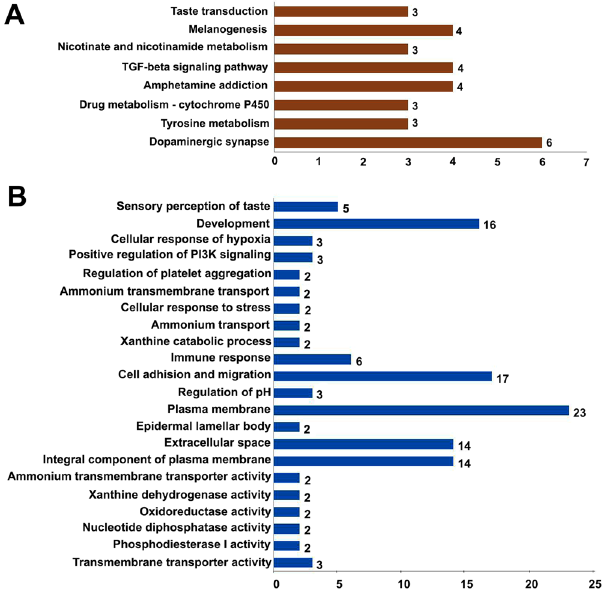
Figure 5. Histogram presentation of the number of DEGs between GE vs NGE of the base of oral cavity belonging to significant pathways ( A ) and selected gene ontology (GO) terms ( B ).